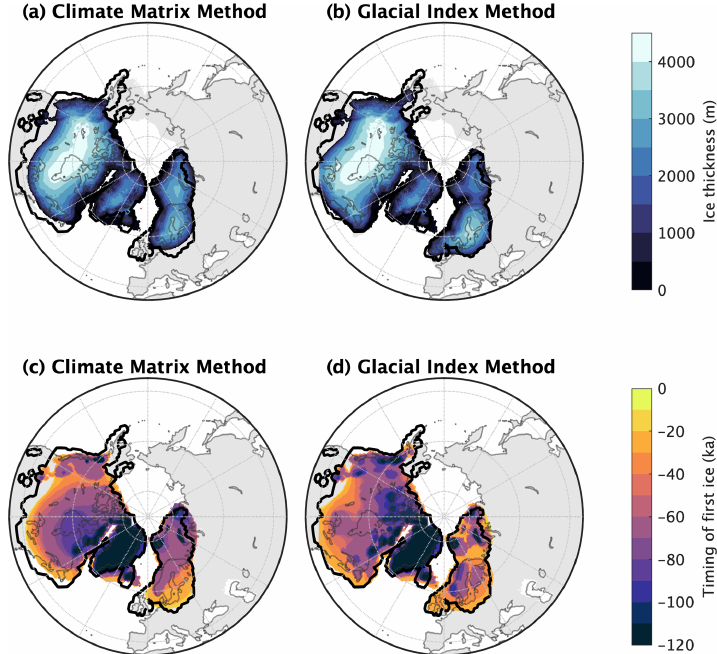
Figure 8. Ice thickness (a, b) and timing of first ice (c, d) of the climate matrix (a, c) and glacial index (b, d) methods. The black contour represents the extent of the ice reconstruction by Abe-Ouchi et al.